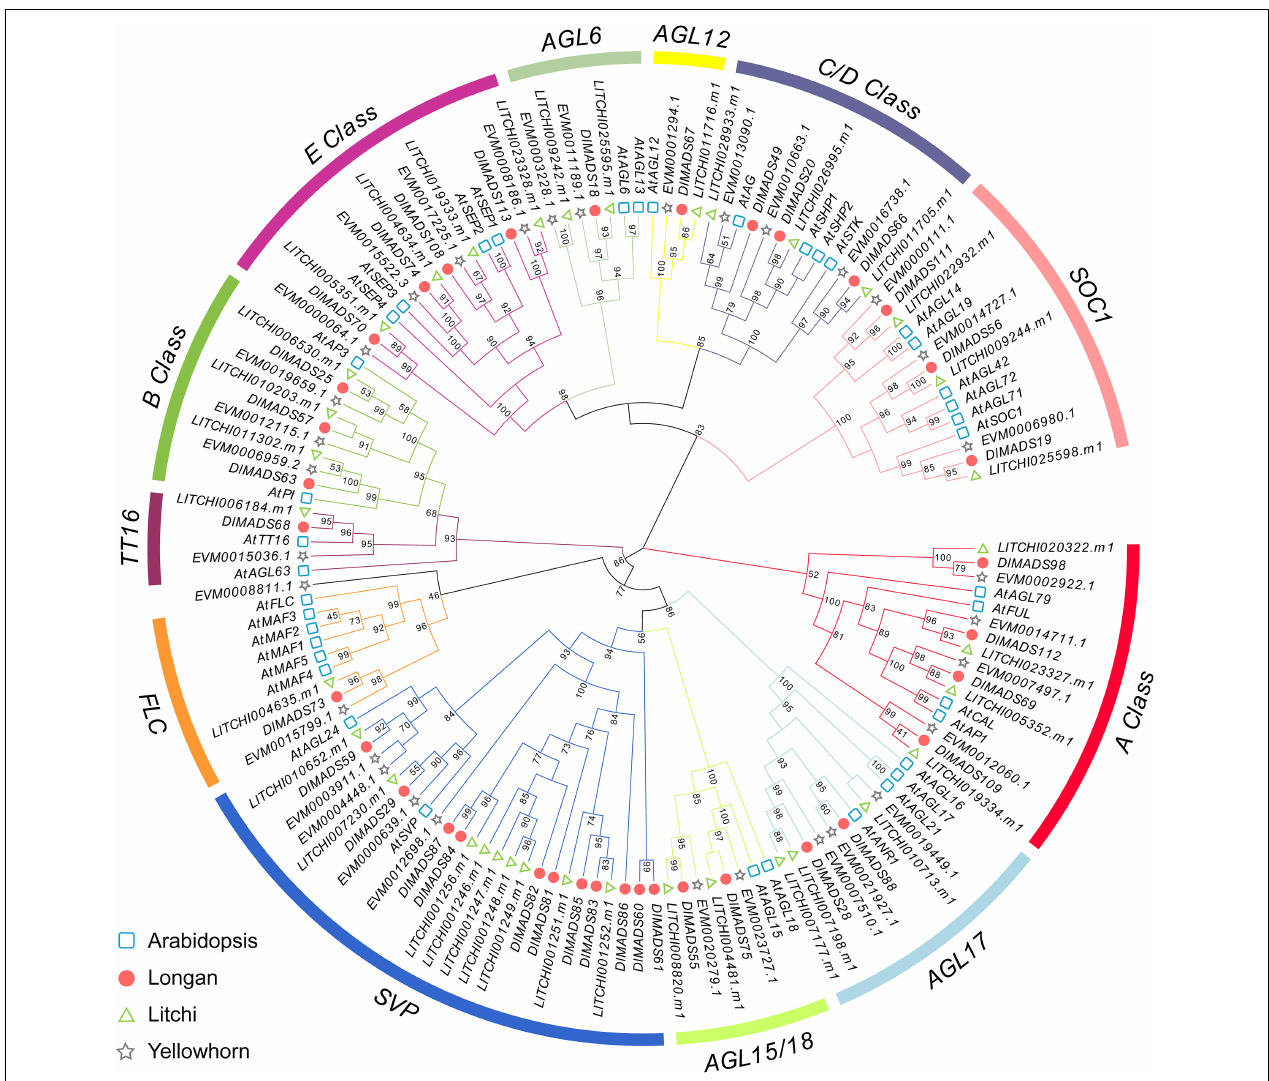
FIGURE 2 | Phylogenetic analysis of type II MADS-box transcription factors. The maximum-likelihood (ML) tree was constructed with MIKC C proteins sequences from Arabidopsis ( At ), longan ( Dl ), litchi ( LITCHI ), and yellowhorn ( EVM